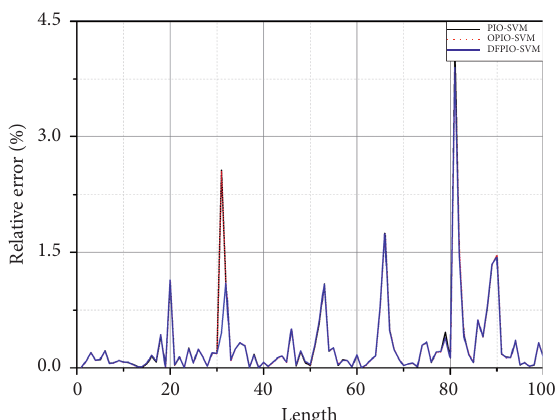
Figure 11: The prediction error curves of three methods for the temperature of PV panels.